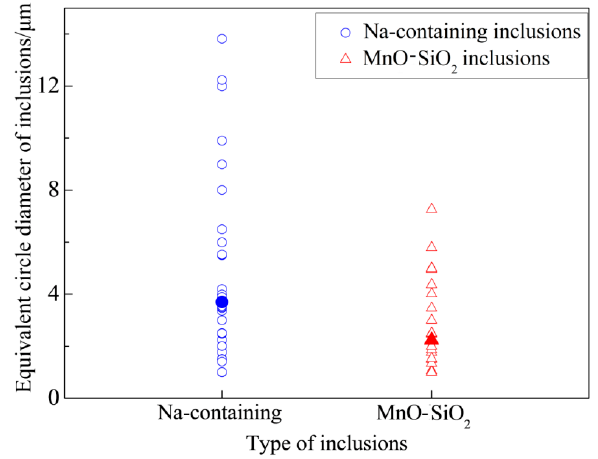
Figure 12. Relationship between size and type of inclusions (the filled symbols denote the average size of a certain type of inclusion).